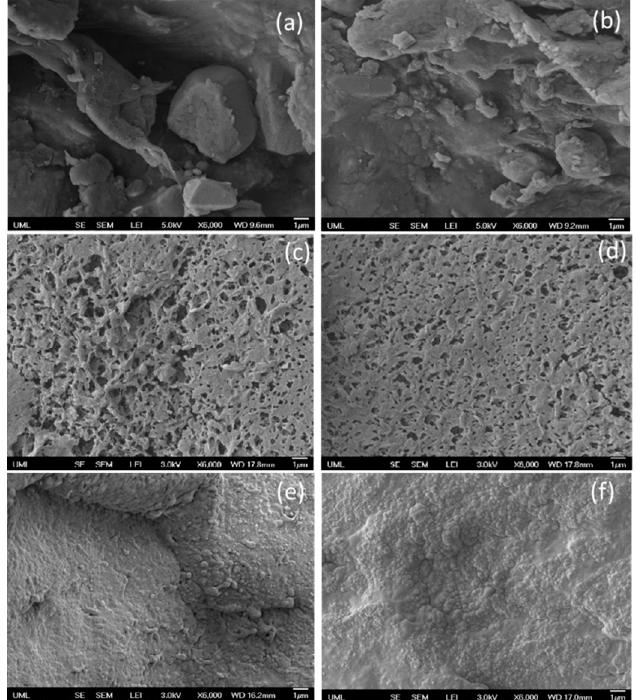
Figure 6. Morphology as observed by field emission scanning electron microscopy (FESEM) for ( a ) cryo-fractured surface of 3D printed 40 PP/60 SEBS ( w / w ) binary blend, ( b ) cryo-fractured surface of injection molded 40 PP/60 SEBS ( w / w ) binary blend, ( c ) etched morphology of the 3D printed 40 PP/60 SEBS ( w / w ) binary blend, ( d ) etched morphology of the injection molded 40 PP/60 SEBS ( w / w ) binary blend, ( e ) cryo-fractured surface of 7.5 phr carbon black loaded 3D printed 40 PP/60 SEBS ( w / w ) binary blend, and ( f ) cryo-fractured surface of 15 phr carbon black loaded 3D printed 40 PP/60 SEBS ( w / w ) binary blend. Table 3. Surface tension of PP and SEBS at room temperature [17,23,24] and the calculated interfacial tension values as per Equation (2).